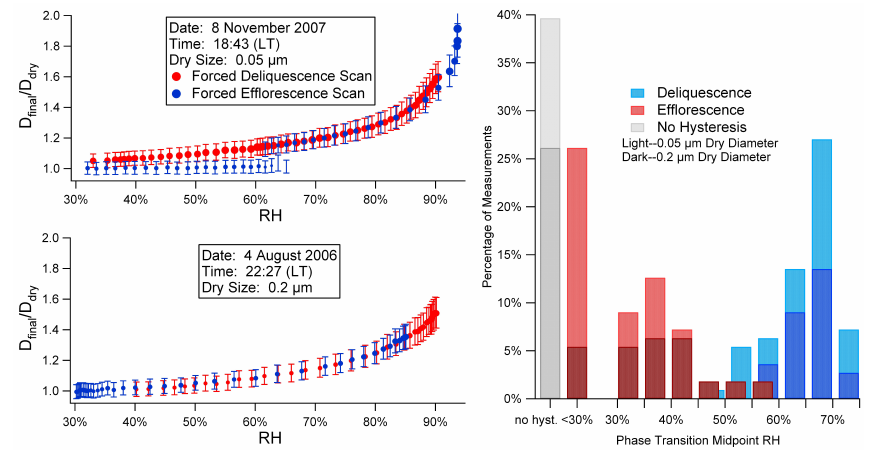
Fig. 5. H-TDMA example scans and winter H-TDMA detected phase transition summary. The points in the H-TDMA scans follow the convention established at the end of Sect. 2.3.